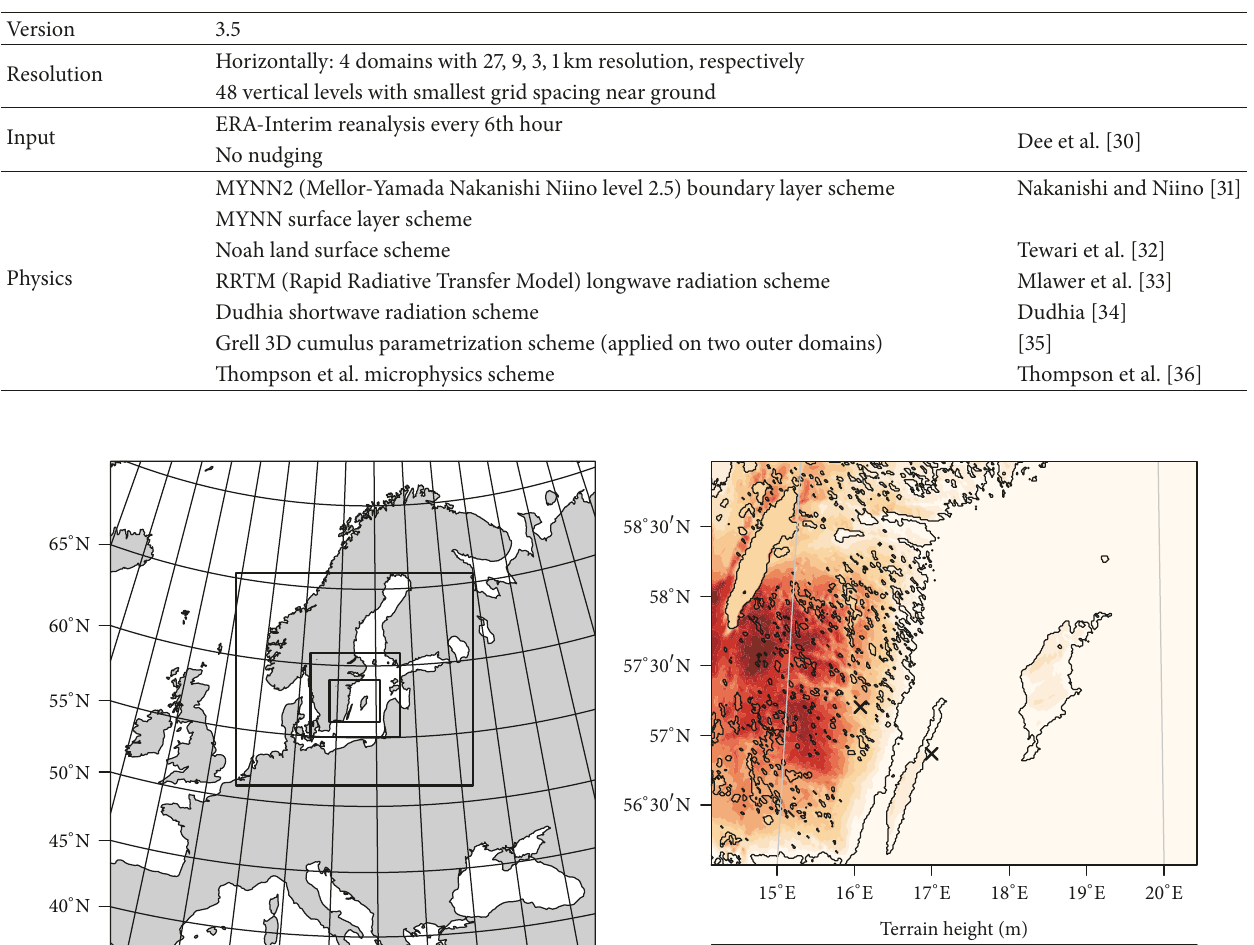
Table 1: WRF simulation settings used for this study.